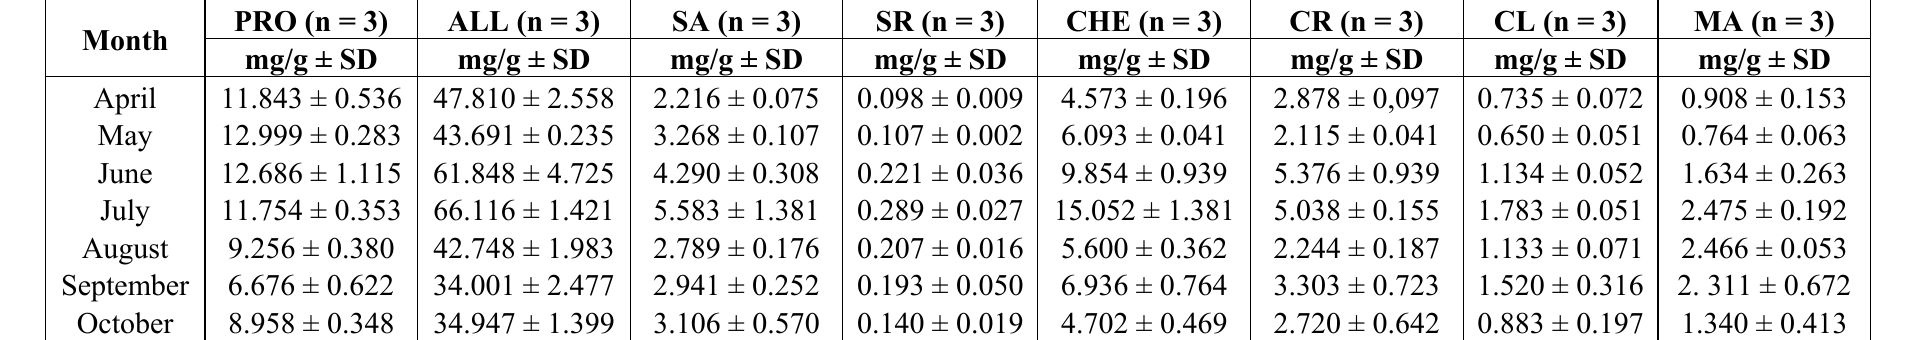
Table 4. The amount of isoquinoline alkaloids during the vegetation period—underground parts of M.